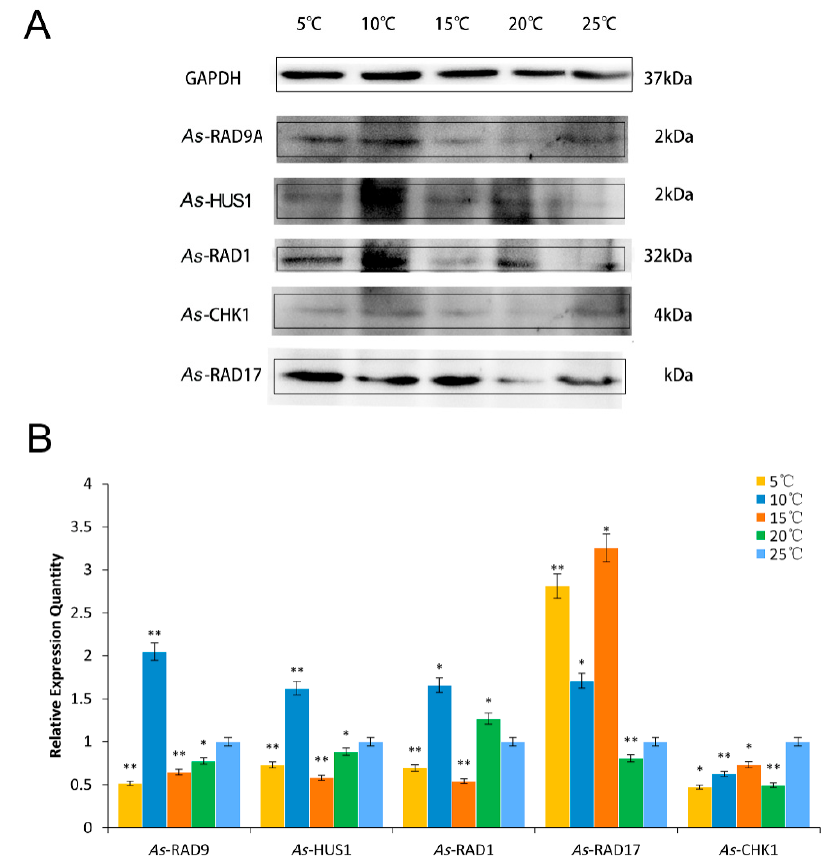
Figure 6. Western blot analyses of As– RAD9, As– HUS1, As– RAD17, As– RAD1, and As– CHK1 proteins in response to temperature stresses. ( A ) The band intensity of the proteins is normalized to the band intensity of GAPDH. ( B ) The values are expressed as an arbitrary unit of relative value. Protein expression at 25 °C as control (blue), asterisk (**) indicates a statistical difference at P < 0.01, and (*) indicates 0.01 < P < 0.05.